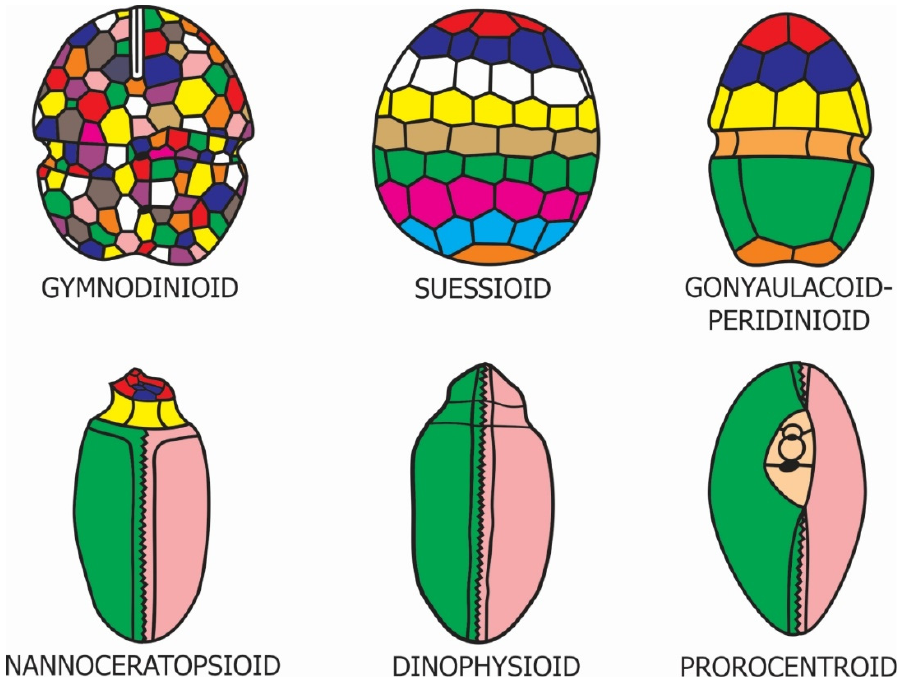
Figure 16. The six principal dinoflagellate tabulation styles illustrated by idealised drawings of the cell or cyst as appropriate. Top left: gymnodinioid tabulation type in ventral view. Top centre: suessioid tabulation type in dorsal view. Top right: gonyaulacoid–peridinioid tabulation type in dorsal view. Bottom left: nannoceratiopsioid tabulation type in dorsal view. Bottom centre: dinophysioid tabulation type in dorsal view. Bottom right: prorocentroid tabulation type in oblique view. The different colours are used to enhance the clarity of the tabulation pattern; where appropriate, lateral plate series are given the same colour. Adapted from Fensome et al. [43].